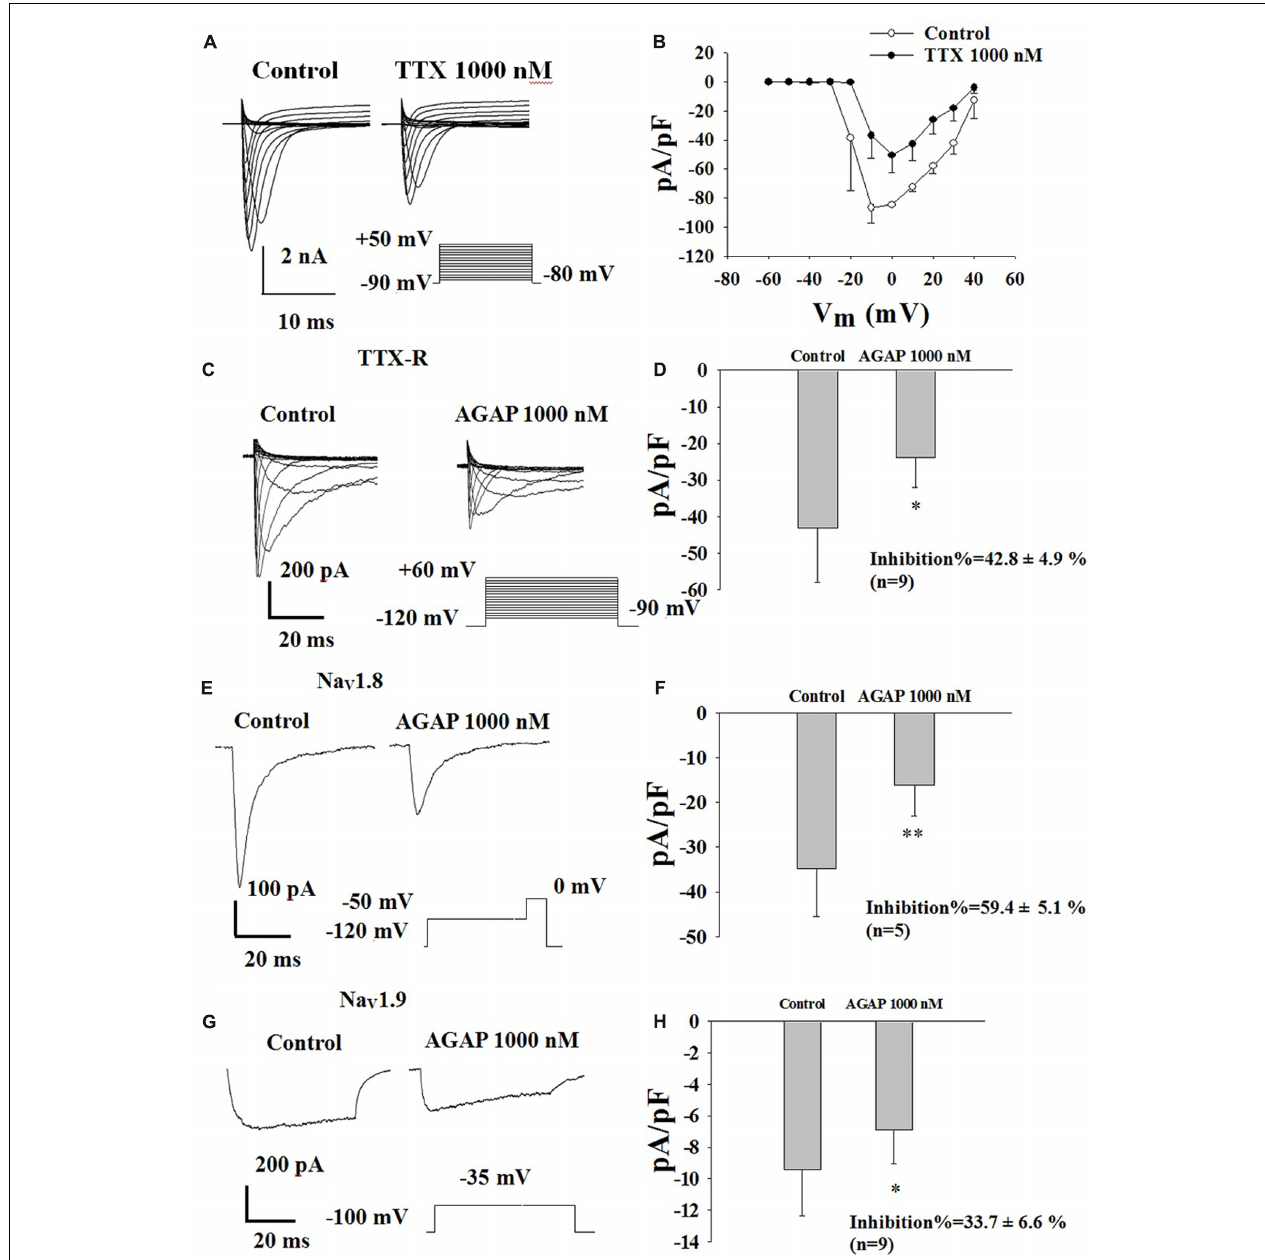
FIGURE 7 | Effect of AGAP on the TTX-R sodium currents in small-diameter DRG neurons. (A) Representative traces showing the depression of 1000 nM TTX on Na V channel currents in rat small diameter DRG neuron. (B) Current density-voltage relationship obtained by plotting current density as a function of test potential under control conditions and after application of 1000 nM TTX ( n = 6). (C) Representative traces showing the depression of AGAP on TTX-R currents in a neuron. (D) 1000 nM AGAP inhibited TTX-R currents by 42.8% ( P < 0.05, P values are from unpaired t -test, n = 9). (E) Representative traces showing the depression of AGAP on Na V 1.8 currents in a neuron. (F) At a concentration of 1000 nM, AGAP potently inhibited Na V 1.8, decreasing current amplitude by 59.4% ( P < 0.01, P values are from unpaired t -test. n = 5). (G) Representative traces showing the depression of AGAP on Na V 1.9 currents in a neuron. (H) 1000 nM AGAP reduced Na V 1.9 currents by 33.7% ( P < 0.05, P values are from unpaired t -test. n = 9).